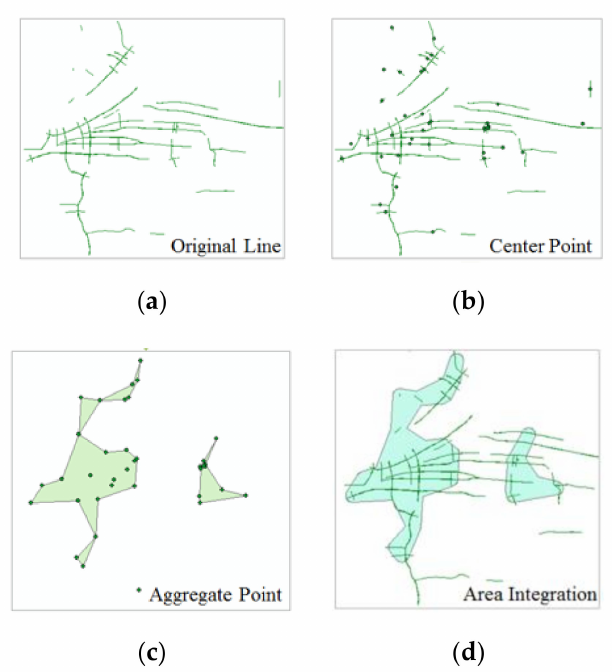
Figure 3. The three-step workflow of gathering featured functional areas. ( a ) Original street lines; ( b ) extracted center points of lines; ( c ) the aggregated area from points; ( d ) the modified aggrega- tion